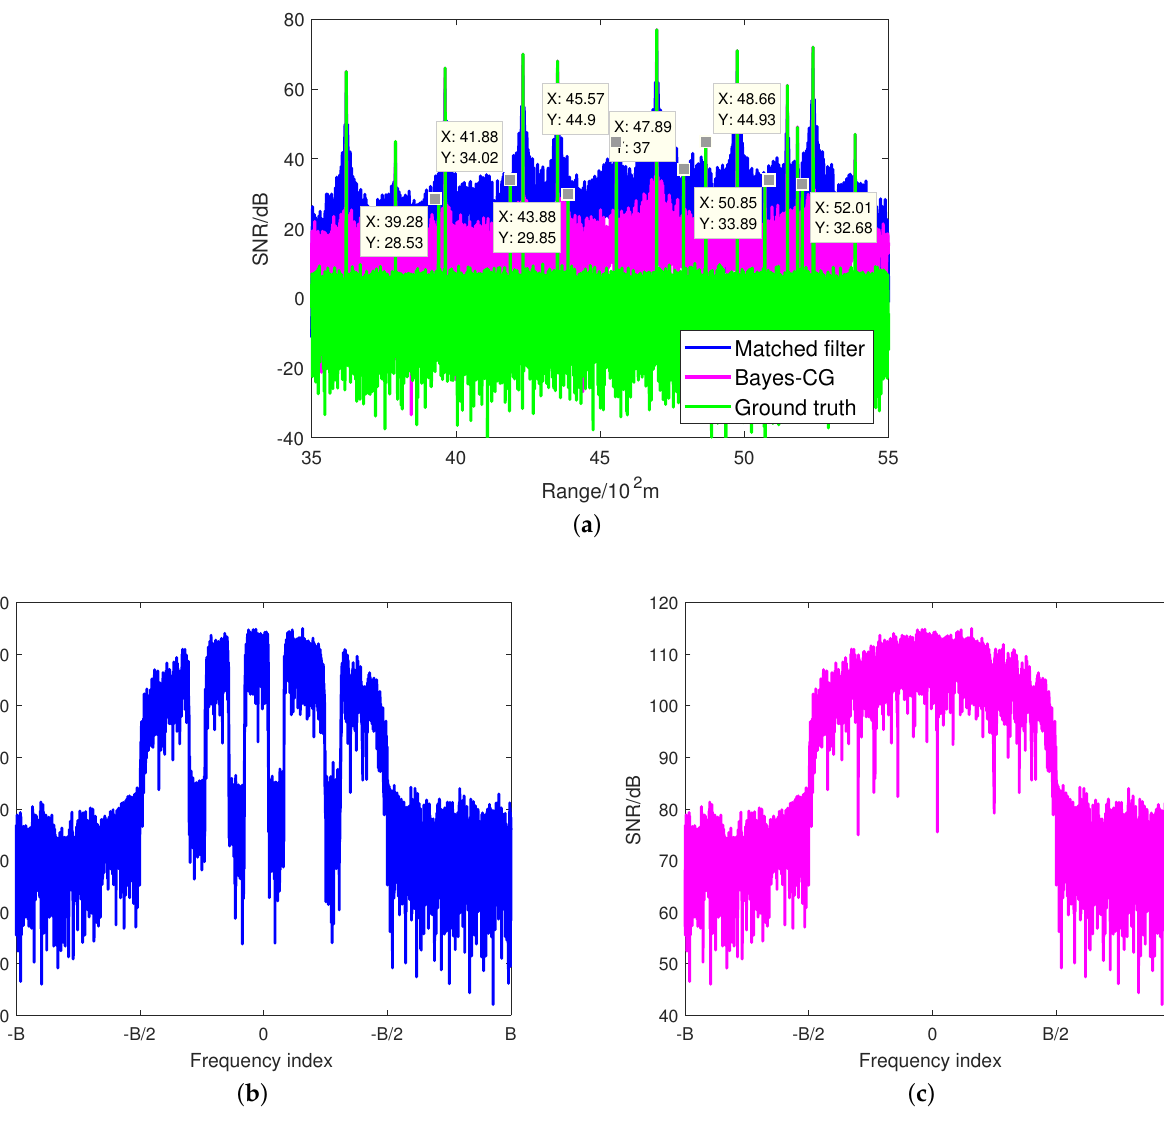
Figure 7. ( a ) Target estimation comparison between matched filtering and Bayes–CG algorithm, where η = 75%. ( b ) PSD of the target estimation result using a standard matched filter; ( c ) PSD of the target estimation result using the Bayes–CG